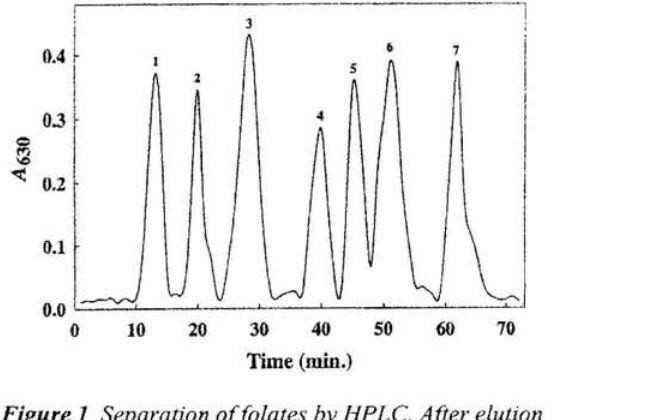
Figure 1 Separation of folates by HPLC. After elution with 10% (v/v) ethanol (see Material